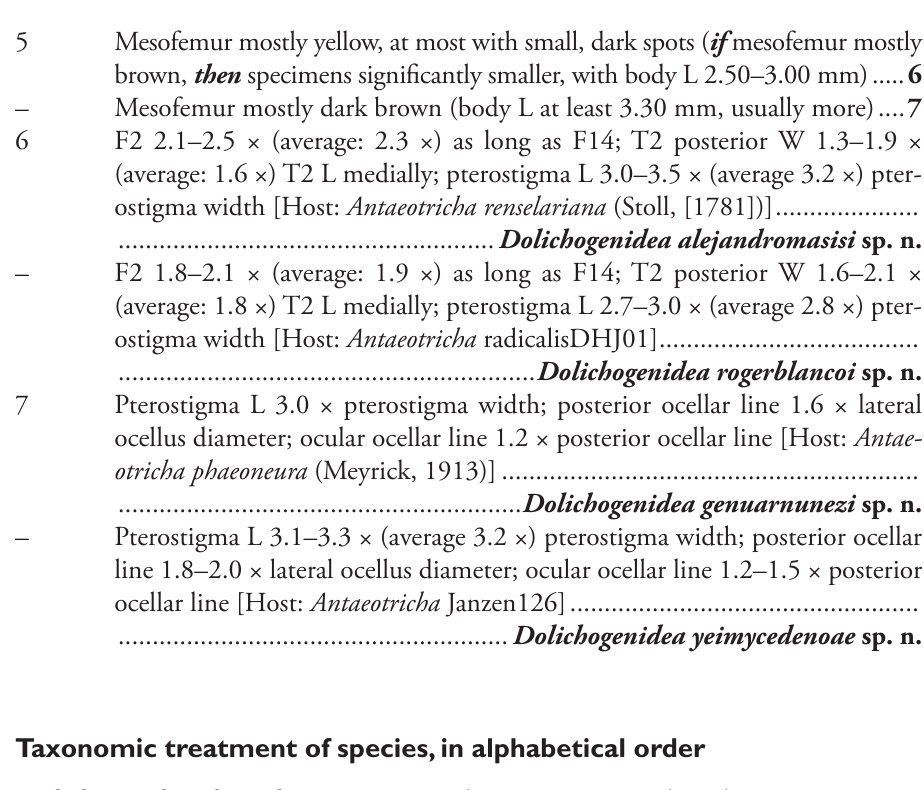
Holotype. Female, Costa Rica,